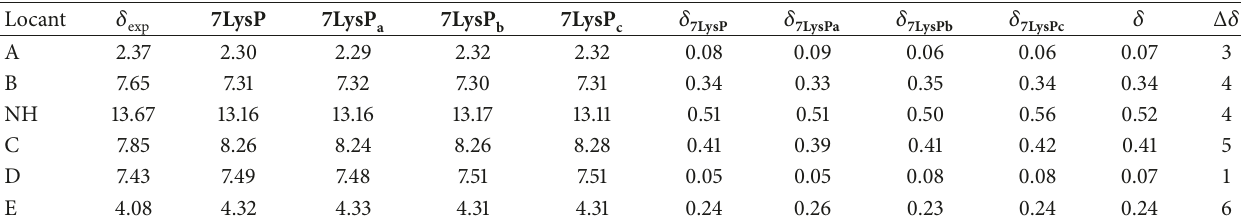
Table 3: Experimental ( 𝛿 exp ) and calculated chemical shifts(rotamers 7LysP – 7LysP c )for compound 7 within the 7Lys adduct; absolute errors ( 𝛿 7LysP – 𝛿 7LysPc ), average absolute error ( 𝛿 ), and relative percentage errors ( Δ𝛿 ); calculated NMR shielding for proton 𝐻 ref = 31.6651 ppm